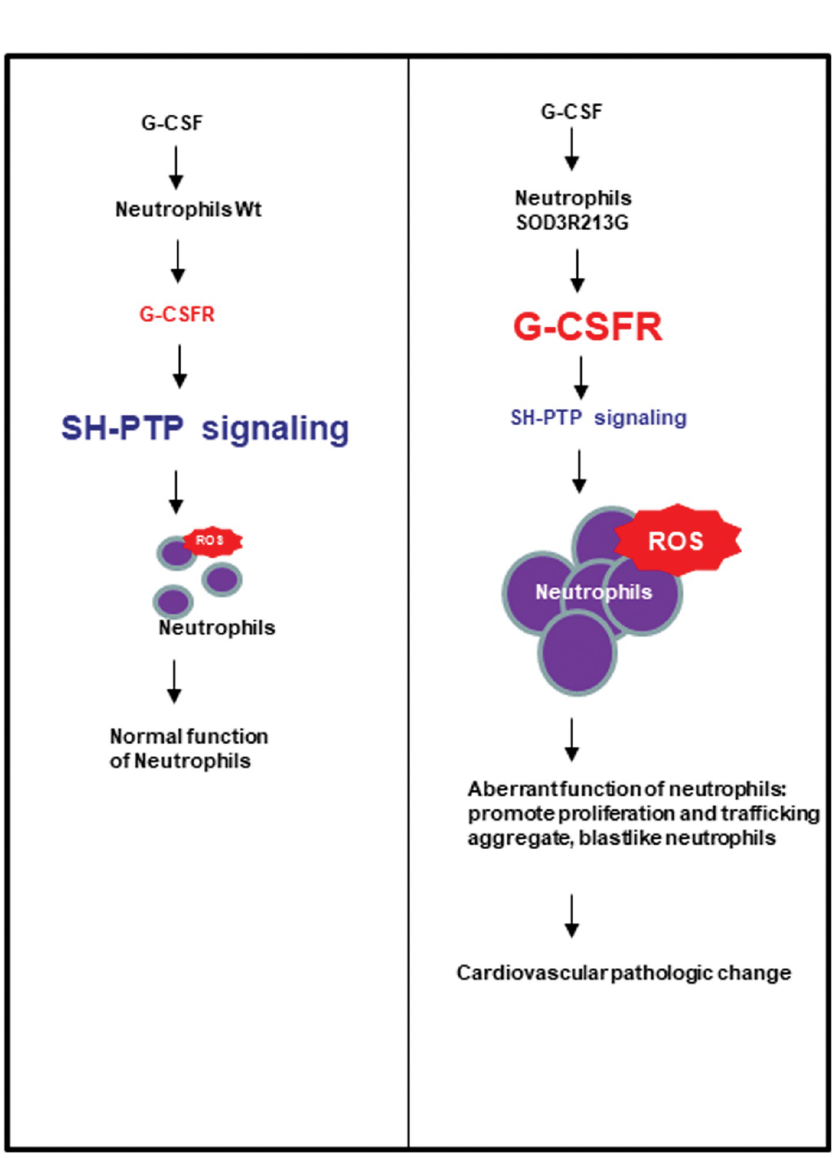
Fig 7. Proposed mechanism of cardiovascular pathologic change in SOD3 R213G mice. Neutrophils of SOD3 R213G mice are dominantly infiltrated in their organs in response to G-CSF, promoting proliferation and trafficking to their organs. Neutrophils of SOD3 R213G mice are sensitized, and down-regulated SH-PTP signaling in response to G-CSF may play a major